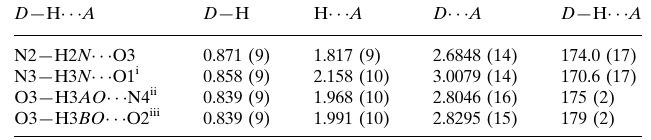
Hydrogen-bond geometry (A˚ , (cid:4)